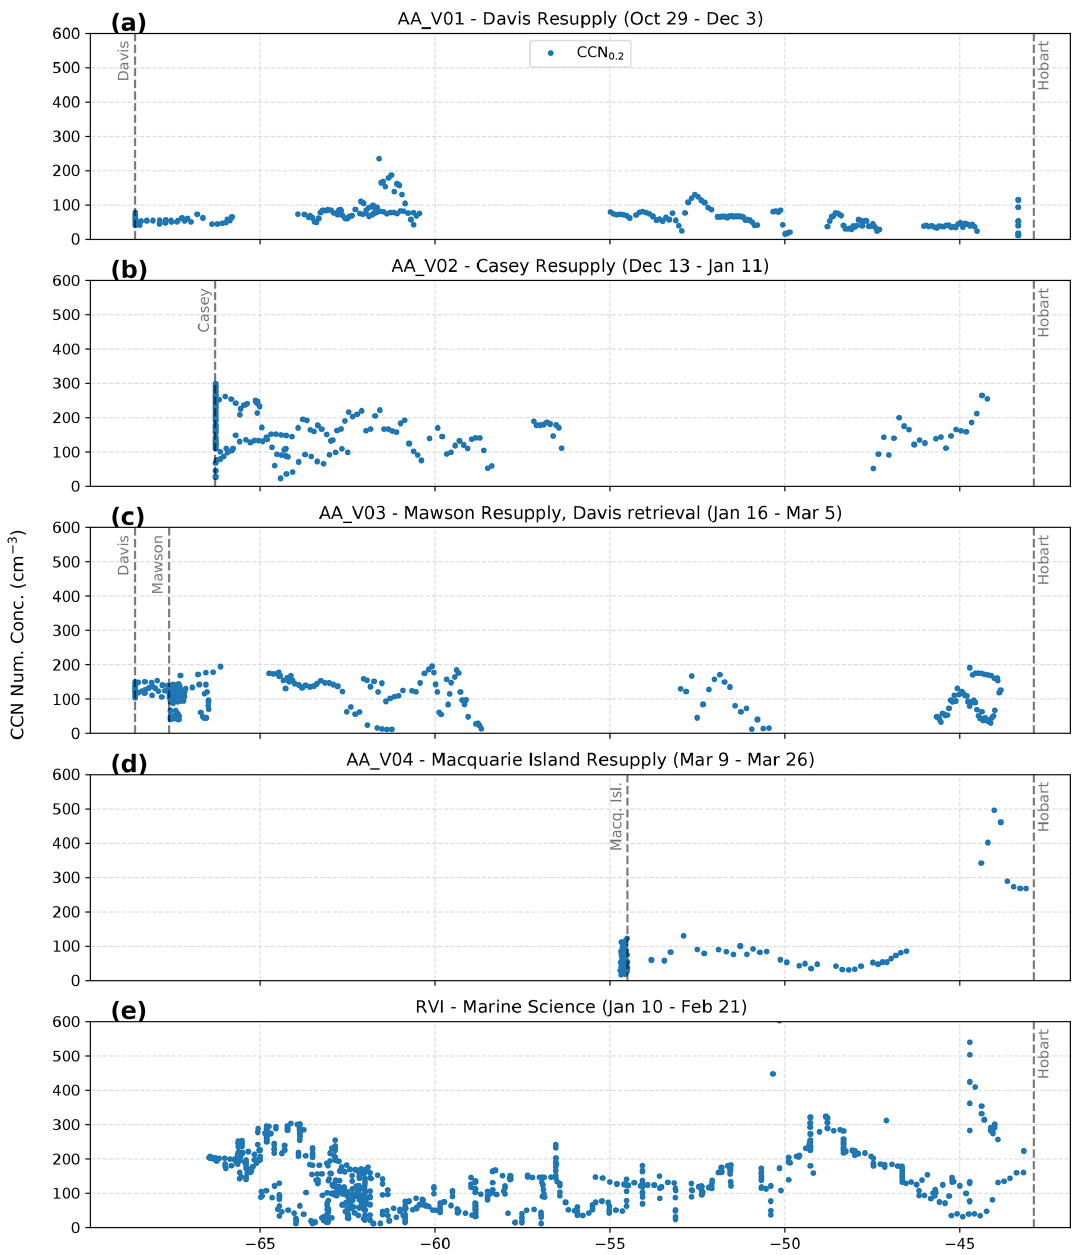
Figure A4. As in Fig. A3 but for CCN 0 . 2